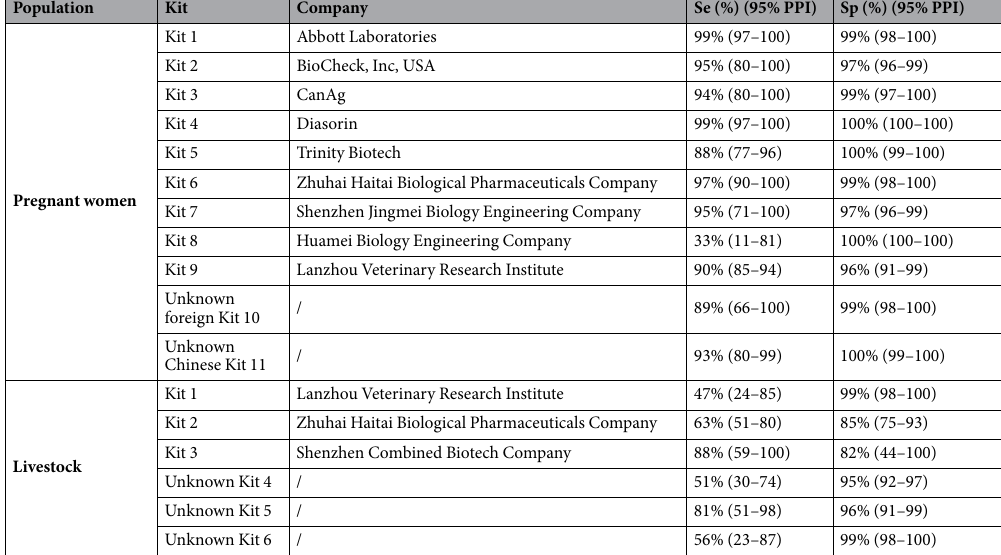
Table 5. Bayesian hierarchical model estimates for sensitivities and specificities of commercial serological kits for detection of anti- T. gondii antibodies in pregnant women and livestock.